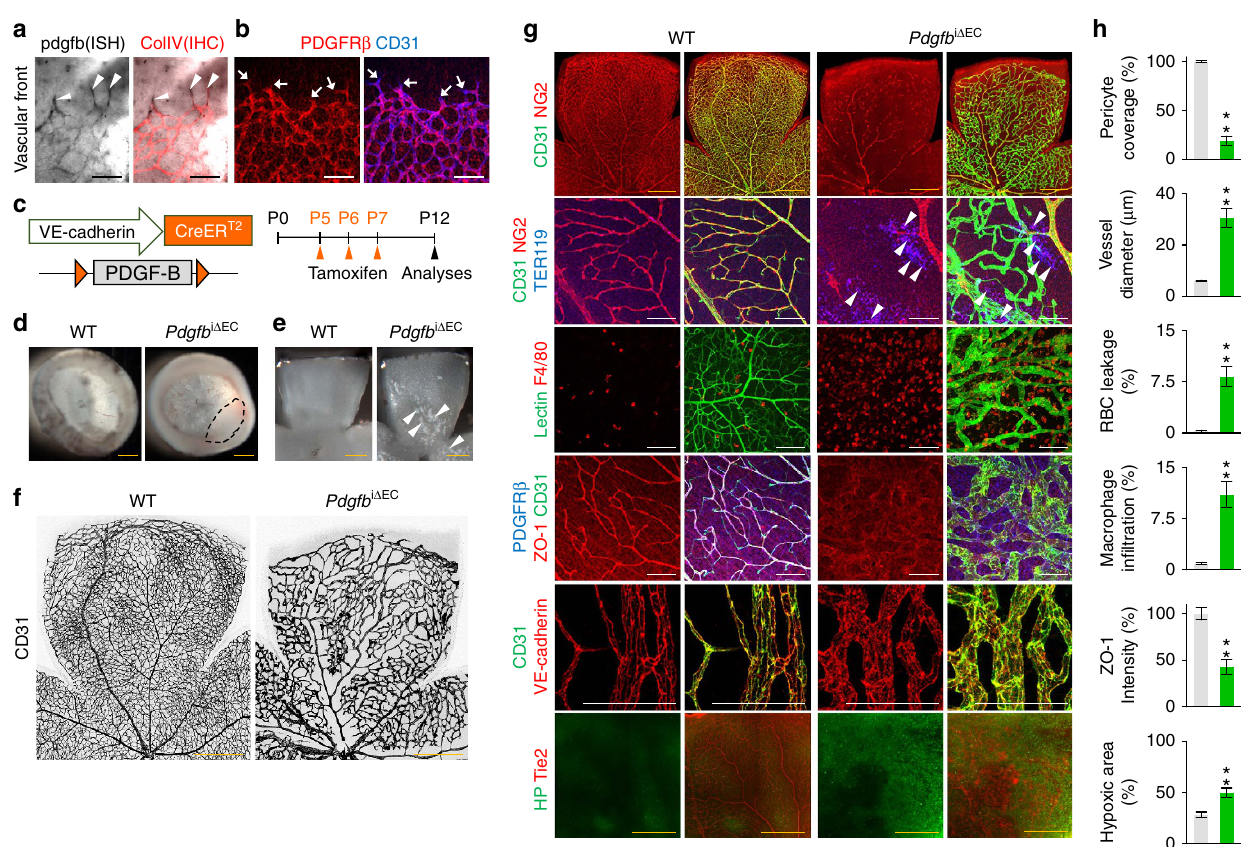
Figure 1 | Pericyte coverage is critical for formation and maturation of BRB. ( a ) Abundant PDGF-B mRNA expression in the tip ECs of vascular front (white arrowheads) at P5. PDGF-B mRNA was analysed by in situ hybridization (ISH), and then collagen type IV (ColIV) was detected by immunohistochemistry (IHC). ( b ) Immunostaining for PDGFR b þ pericytes and CD31 þ ECs in vascular front at P5. Note that there is no pericyte coverage in tip ECs (arrows). ( c ) Diagram for EC-specific depletion of PDGF-B in retinal vessels from P5 and their analyses at P12 using Pdgfb i D EC mice. ( d – f ) Images of hemorrhage (red) and retinal detachment (dashed-line circle) in inner surface of retinal cup, and whitish inflammatory cell accumulations (white arrowheads) and irregular CD31 þ vascular plexus in retinas of Pdgfb i D EC mice are shown. ( g ) Images of NG2 þ and PDGFR b þ pericyte coverage onto CD31 þ vessels, TER119 þ RBC leakage (white arrowheads), F4/80 þ macrophage infiltration, lectin perfusion, distributions of ZO-1 and VE-cadherin onto CD31 þ ECs, and hypoxic area in retinas of WT and Pdgfb i D EC mice are shown. HP, hypoxyprobe. ( h ) Comparisons of indicated parameters in WT (W; n ¼ 6) and Pdgfb i D EC (P; n ¼ 6) mice. Error bars represent mean ± s.d. ** P o 0.01 versus WT by Mann-Whitney U test. Scale bars, 100 m m (white, black) and 500 m m pericyte-free tip ECs but low in ECs of the phalanx and plexus,